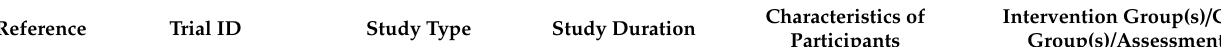
Table 2. Clinical trials of carotenoids against eye